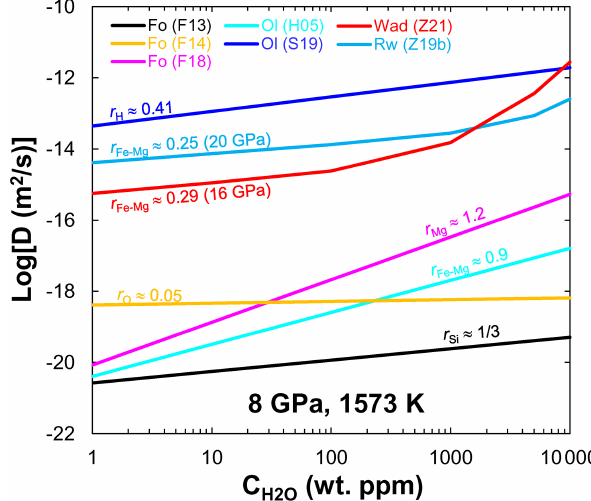
Figure 3. C H dependences of diffusivity in olivine (8GPa), wad- 2 O sleyite (16GPa) and ringwoodite (20GPa) at 1573K. Data sources: F13 (Fei et al., 2013); F14 (Fei et al., 2014); F18 (Fei et al., 2018); H05 (Hier-Majumder et al., 2005); S19 (Sun et al., 2019); Z19b (B. H. Zhang et al., 2019b); Z21 (Zhang et al.,